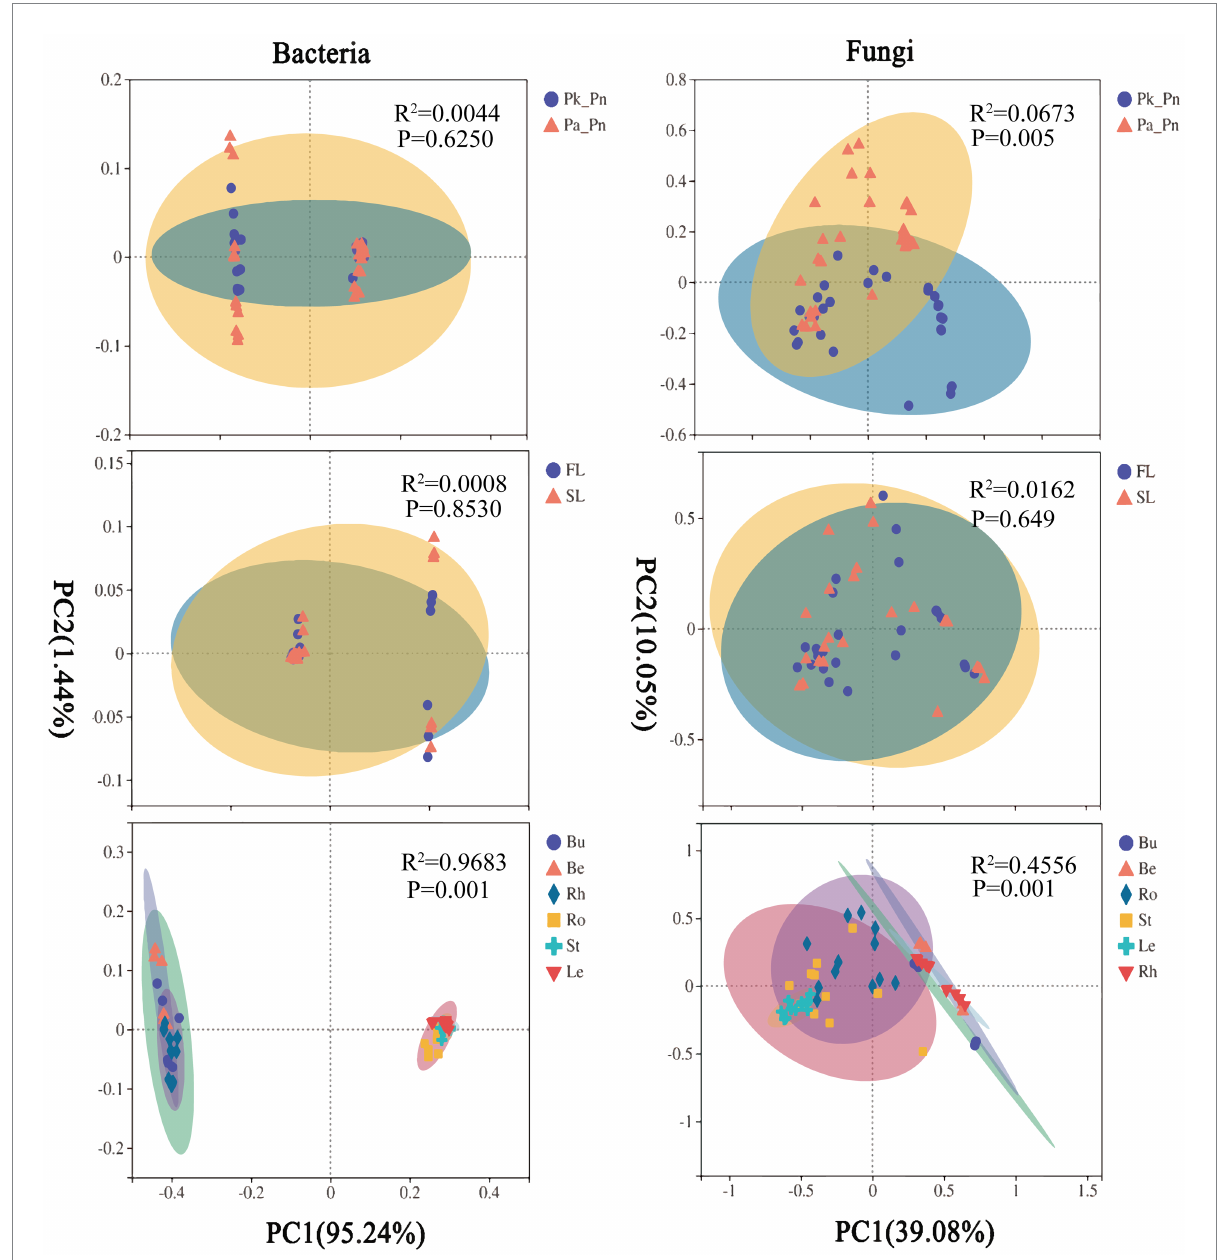
FIGURE 9 PCoA plots based on the WUF of P.n. -associated microbes. Pk_Pn, samples of P.n. under P.n. - P.k. agroforestry system , Pa_Pn , samples of P.n. under P.n. - P.a. agroforestry system, FL, P.n. of three palmately compound leaves and five leaflets, SL, P.n. of two palmately compound leaves and seven